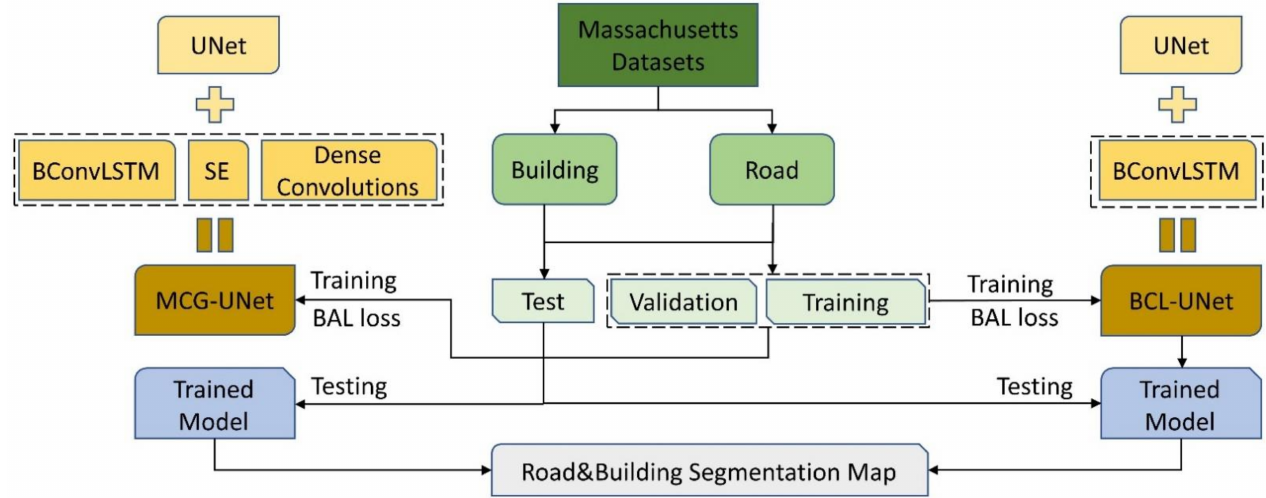
Figure 1. Overall flow of the offered BCL-UNet and MCG-UNet frameworks for multi-object